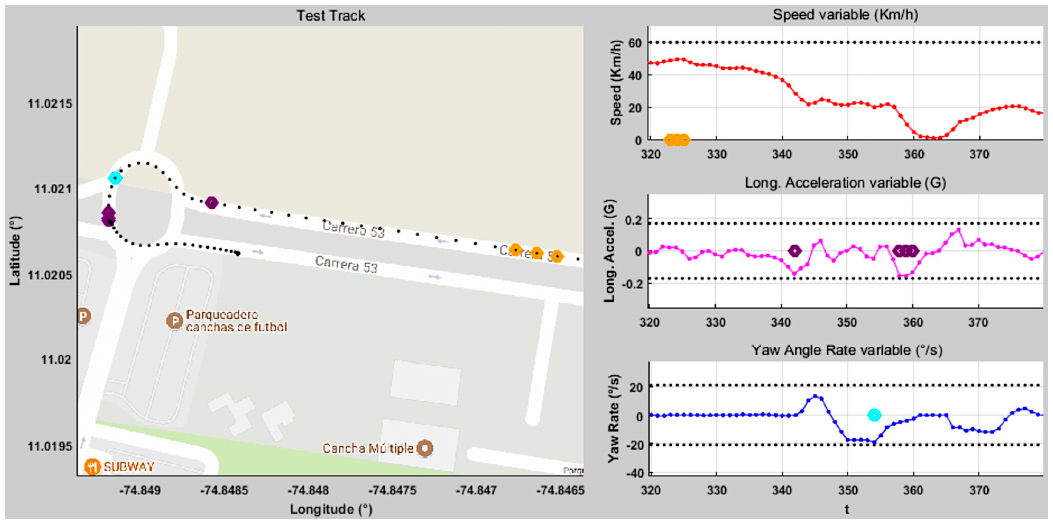
Figure 10. End of Route 2 for driver D 1 assistance results.